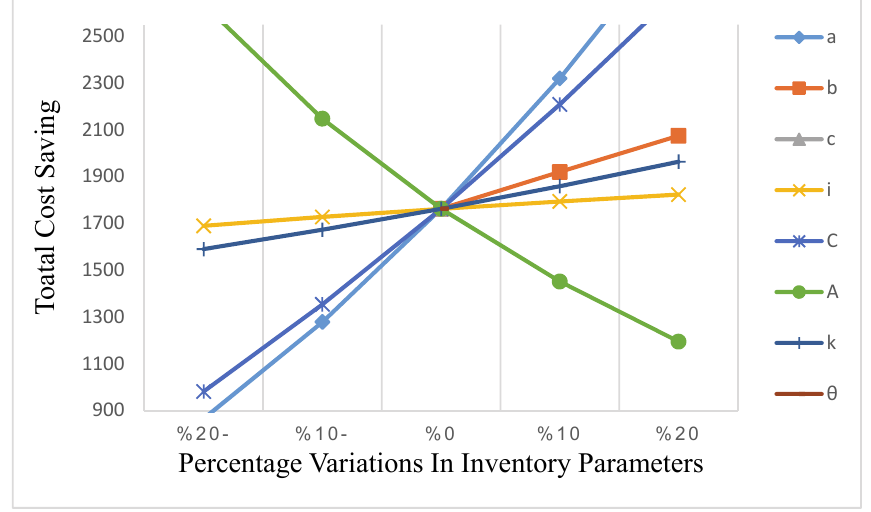
Fig. 7. Variations in total cost